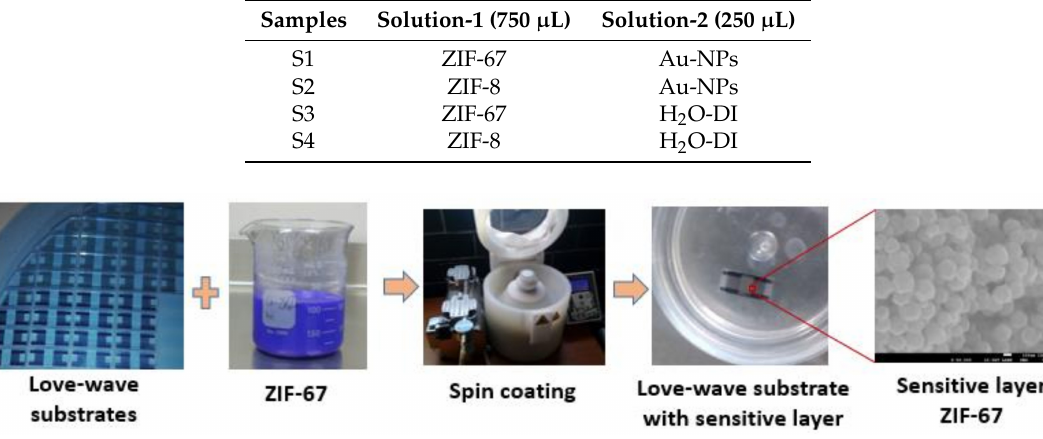
Figure 3. Process sequence of sensitive layer deposition on LW devices using the spin coating